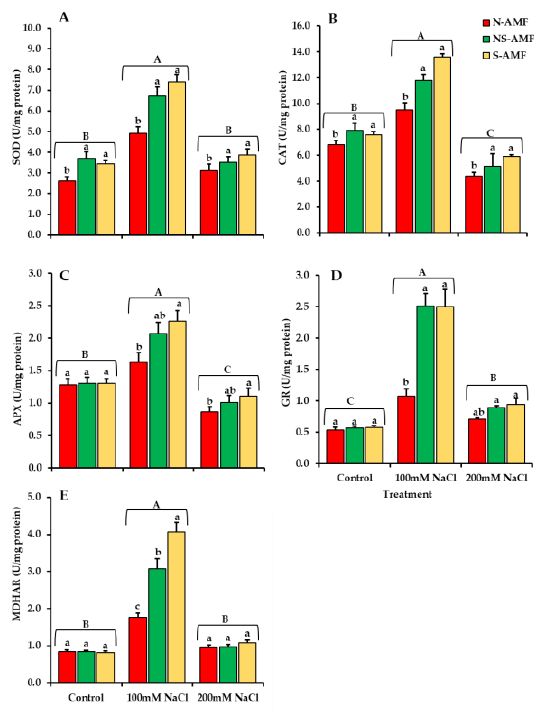
Figure 7. Influence of AM symbiosis (S-AMF and NS-AMF) on SOD (U/mg protein) ( A ), CAT (U/mg protein) ( B ), APX (U/mg protein) ( C ), GR (U/mg protein) ( D ), and MDHAR (U/mg protein) ( E ) activities of L. scindicus plants grown under different salinity stress levels. Capital letters indicate the significance of the salinity effect, while small letters indicate the effect of AM symbiosis at p = 0.05 (Tukey’s HSD test).